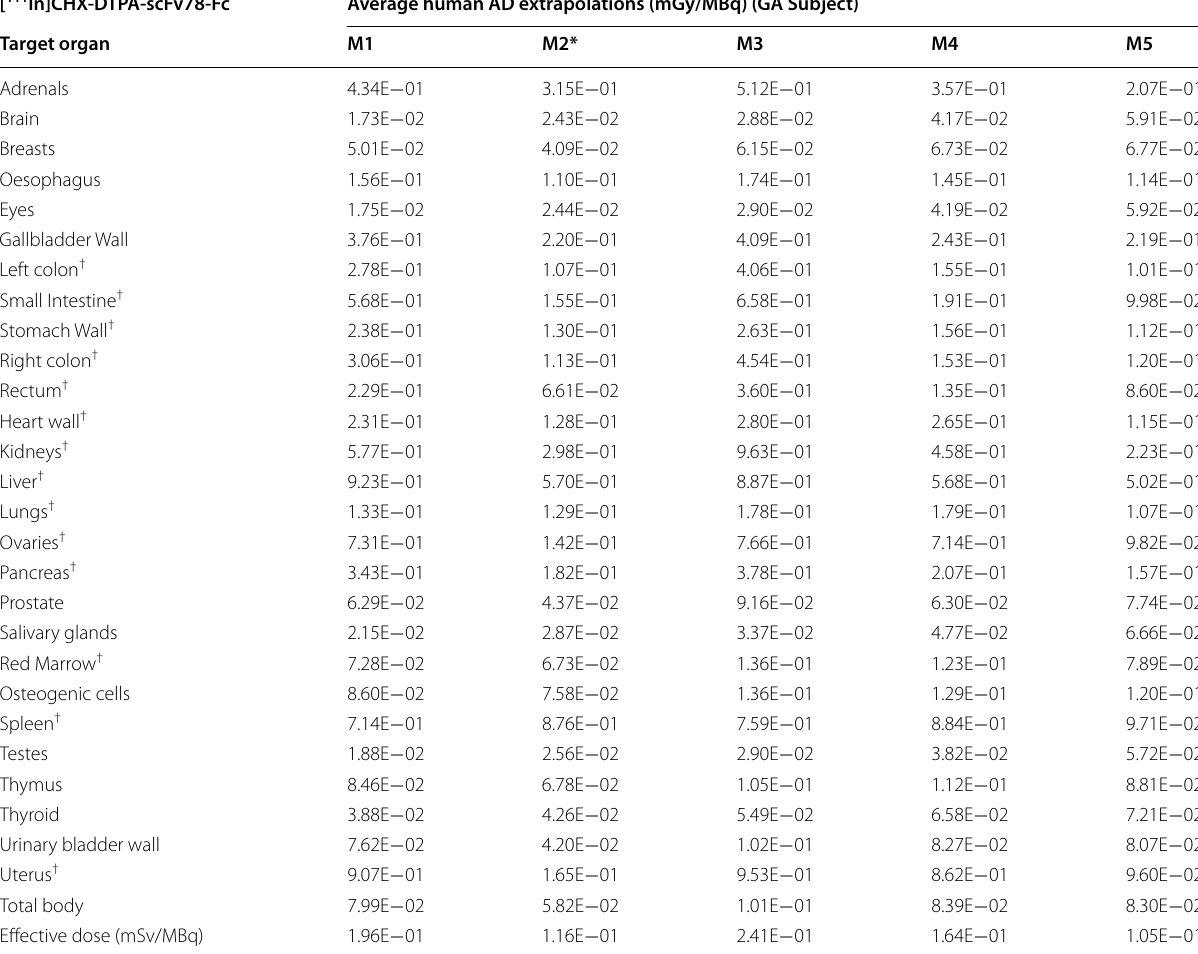
Mouse-to-human dose extrapolations were based on time-integrated activity coefficients (TIACs) obtained from biodistribution data on mice, reported in [24]. Human TIACs were calculated for male and female subjects with five different computational methods and used as input in OLINDA/EXM v.2.1 to derive gender average (GA) organ absorbed doses (ADs) and effective doses (ED) according to the ICRP-103 [32] *Extrapolations according to M2 were already reported in Table 2 of [24]